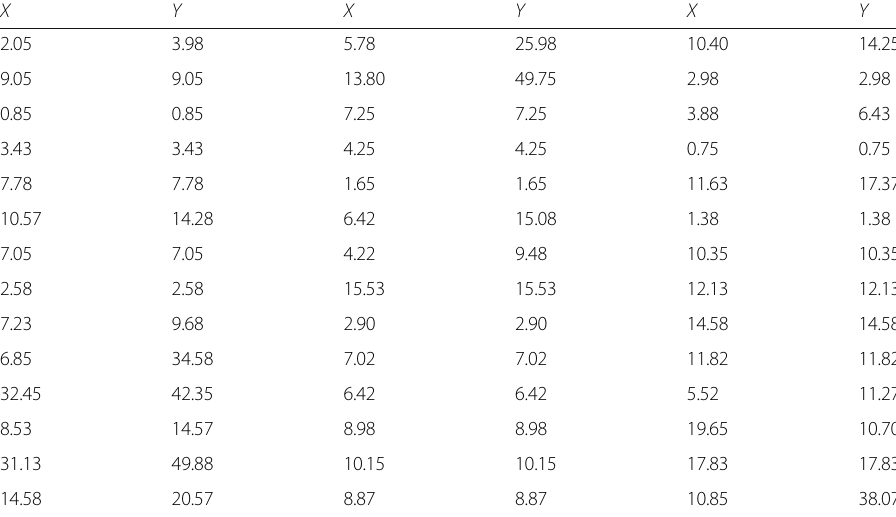
Table 4 American Football League data